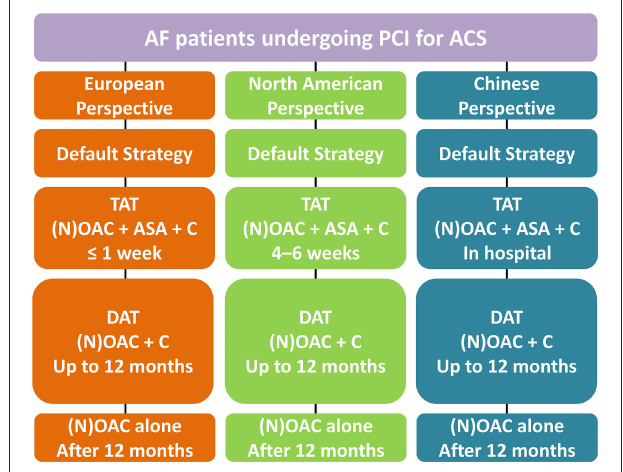
FIGURE 2 | Antithrombotic management in AF patients undergoing PCI for ACS. AF, Atrial fibrillation; PCI, Percutaneous coronary intervention; ACS, Acute coronary syndrome; TAT, triple antithrombotic therapy; NOAC, non-vitamin K antagonist oral anticoagulant; OAC, Oral anticoagulation; ASA, aspirin; C, clopidogrel; DAT, dual antithrombotic